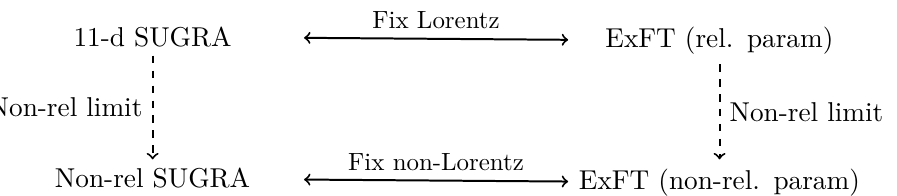
Figure 1 . Relationship between non-relativistic limit and non-relativistic parametrisation of ExFT